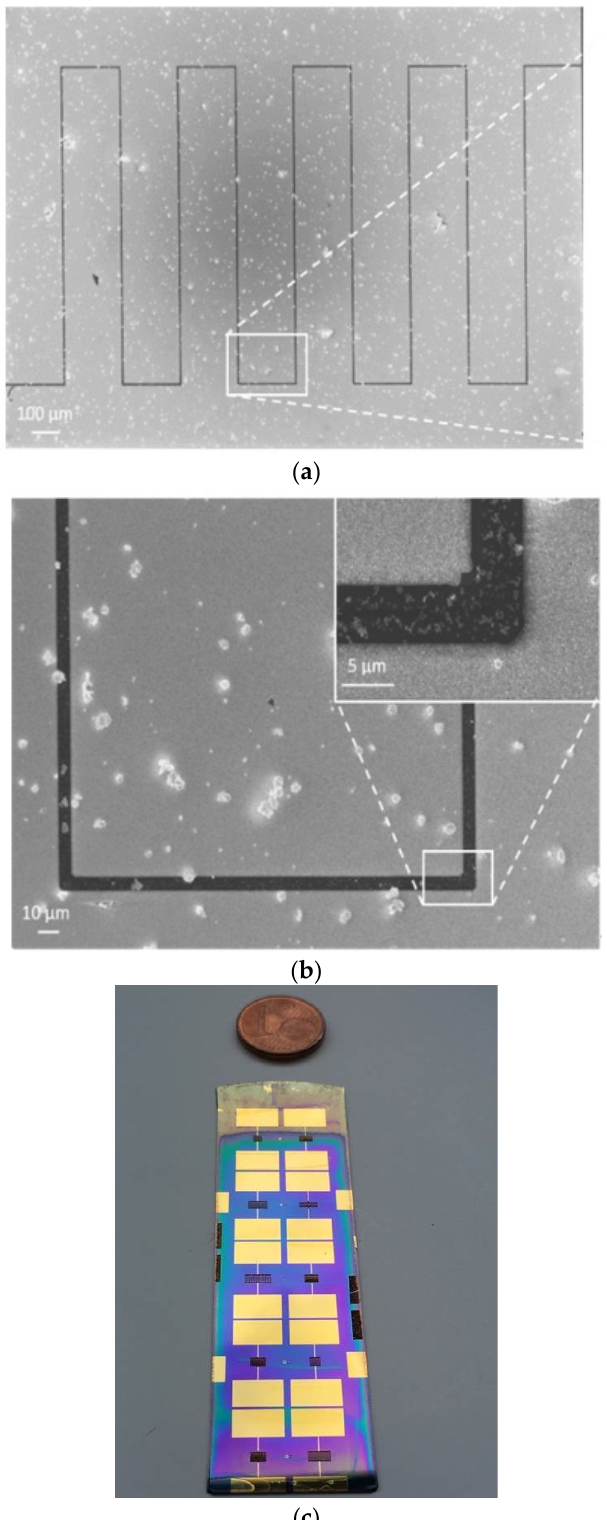
Figure 3. SEM images of the reference sample (w 100 i 5 L 1000 n 10 ) viewed from above with magnification ( a ) ×148 and ( b ) ×1000. The inset represents a zoomed-in view on the angle of a comb. ( c ) Photograph of a piece of silicon substrate containing ten interdigitated microelectrodes and their ohmic contacts.